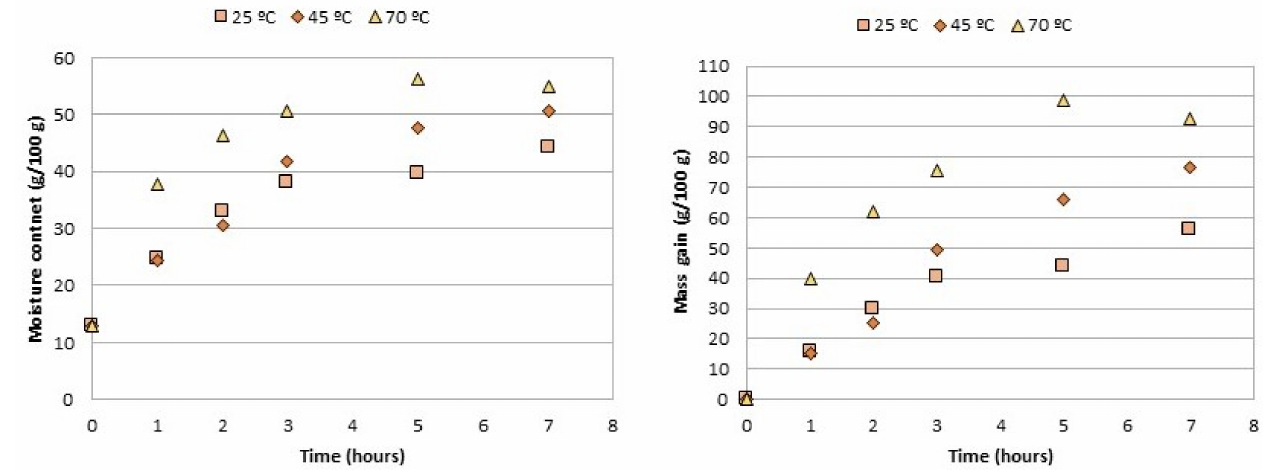
Figure 7. Rehydration procedure: variation of moisture content along time ( left ) and mass gain ( right ).